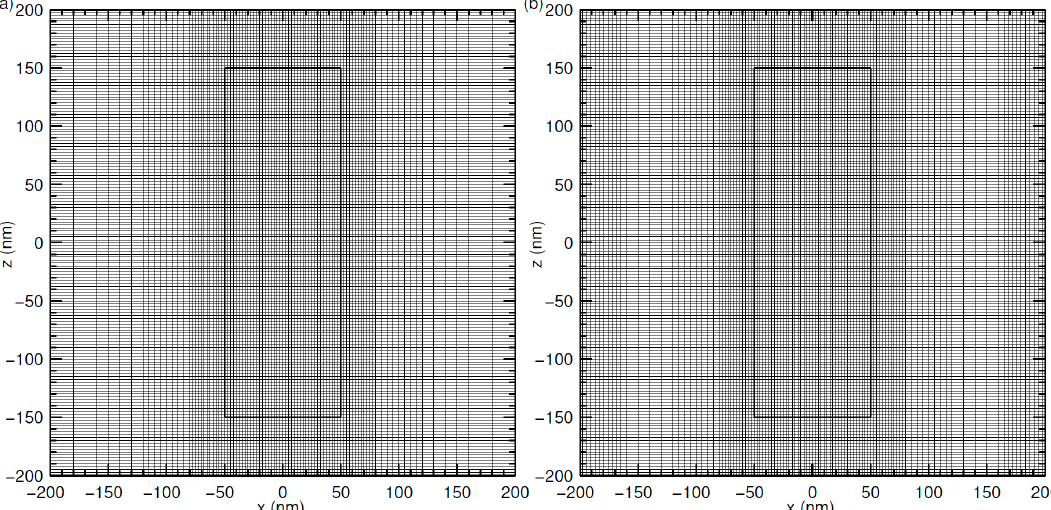
Figure 5. Mesh of the 1D non-uniform grids from ( a ) the multiple-linear mapping function and ( b ) the linear-nonlinear mapping function. The thick lines represent the boundaries of the aperture.